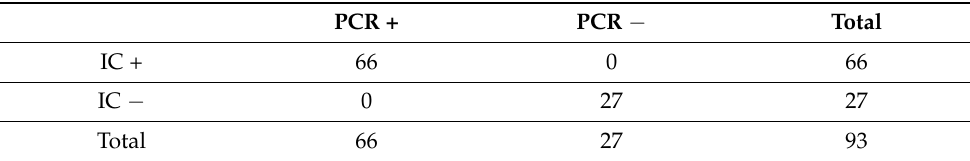
Table 1. IC assay performance as compared with PCR.